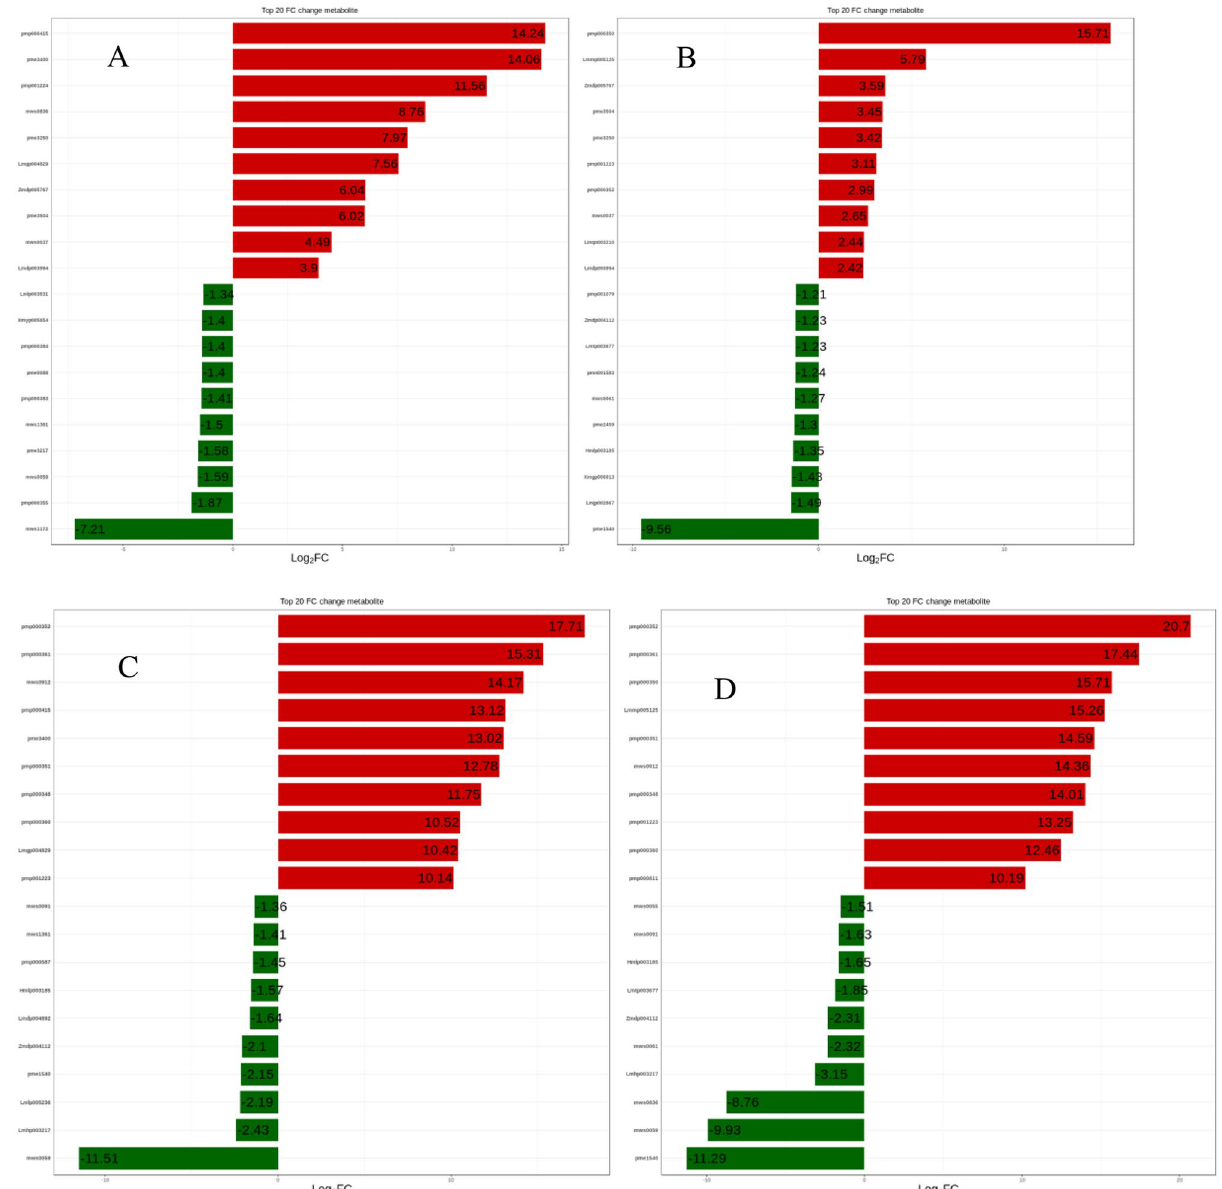
Figure 3. Analysis of the fold difference of metabolites between different samples. ( A ): HN52 vs HN71; ( B ): HNS52 vs HNS71; ( C ): HN52 vs HNS52; ( D ): HN71 vs